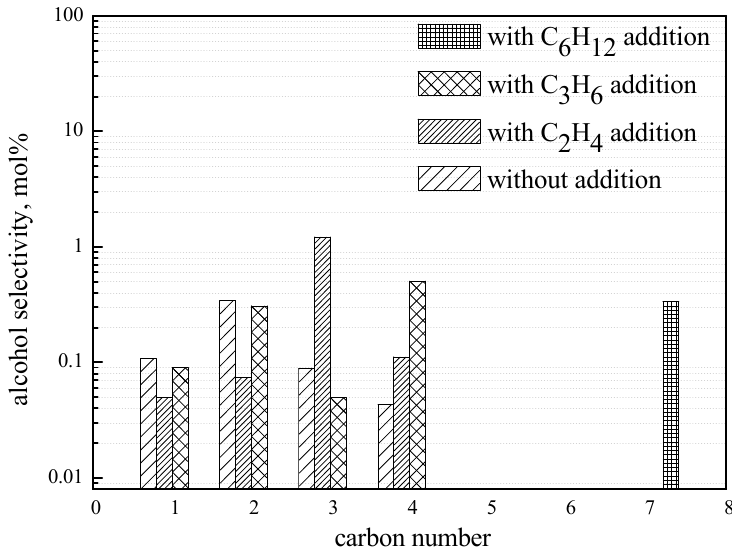
Figure 4. Effects of alkene addition on alcohol selectivity (T = 533 K, p = 0.8 Mpa, H 2 /CO = 12.0, among the addition: H 2 /C 2 H 4 = 4.0, H 2 /C 3 H 6 = 4.1, H 2 /C 6 H 12 = 2.6).